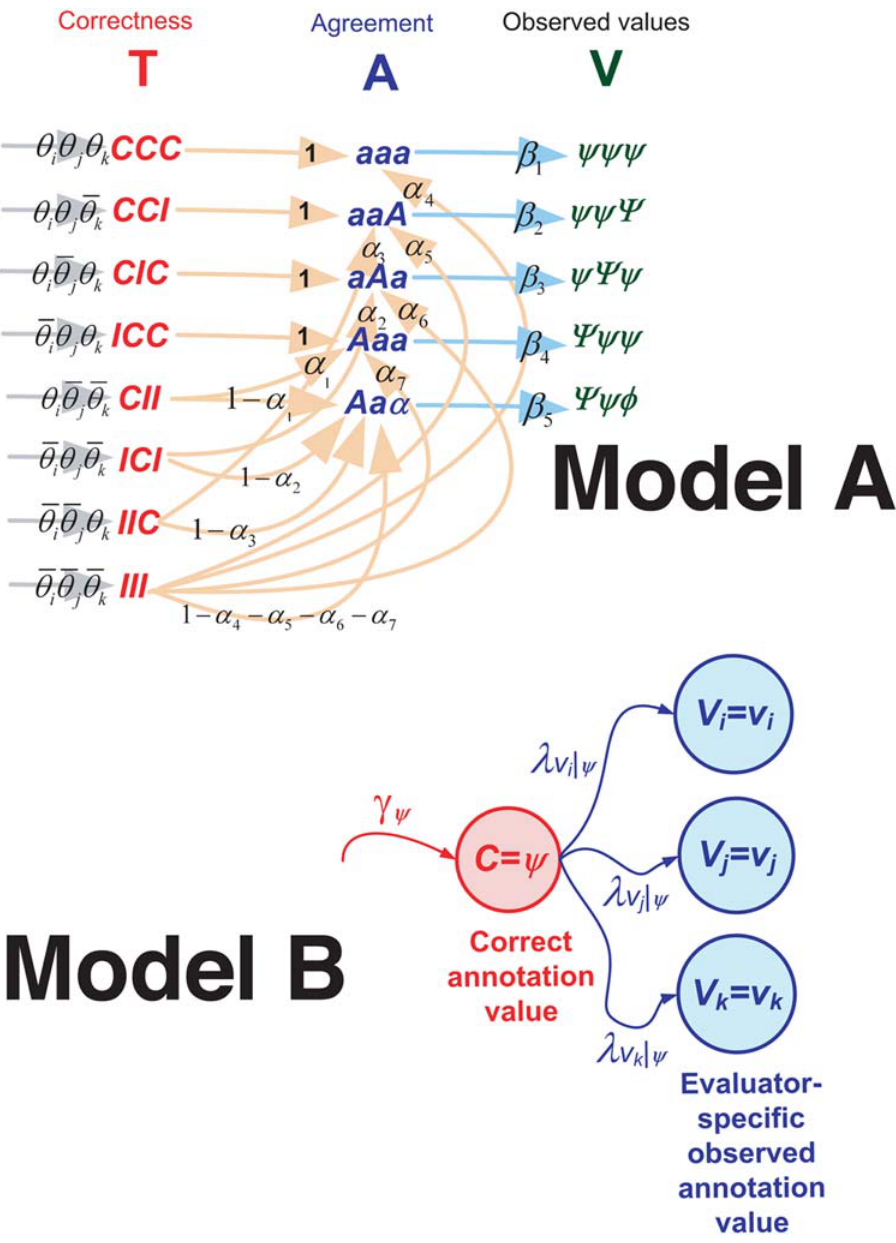
Figure 2. Graphic outline of the two generative models of text annotations introduced in this study (A and B).